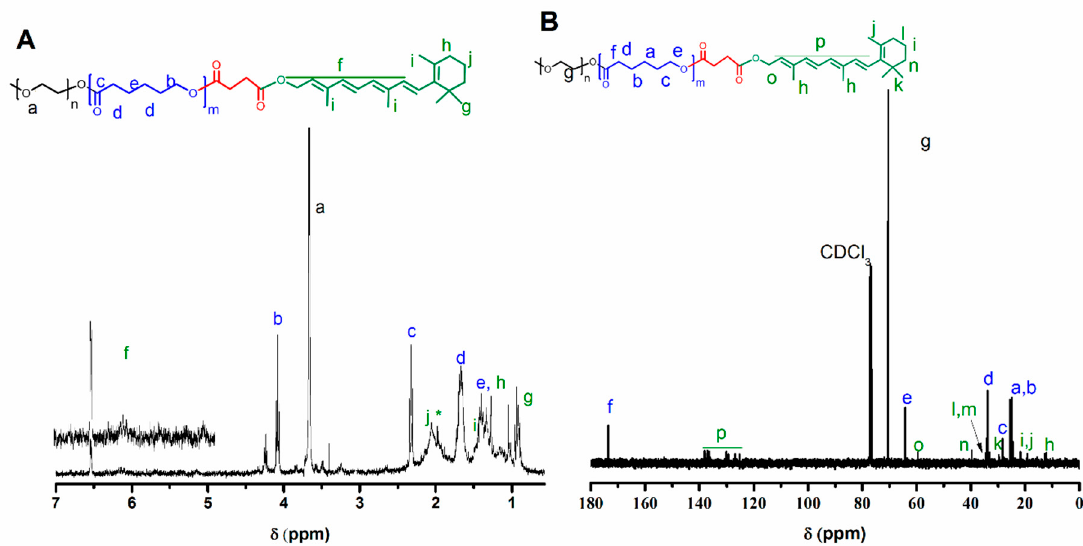
Figure 1. ( A ) 1 H and ( B ) 13 C-NMR spectra of mPEG-b-PCL conjugated with retinol and their corresponding signal designation.